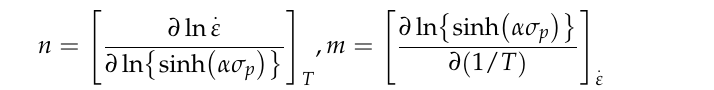
. . ε − σ and ( b ) ln ε − ln σ . Figure 7. Relationship between flow stress and strain rate of the alloy: ( a ) ln 𝜀̇ − σ and ( b ) ln 𝜀̇ − lnσ.